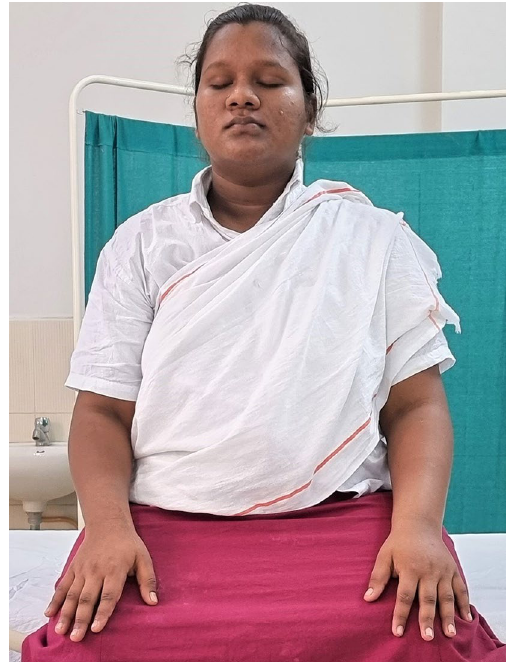
Figure 10. Sukhasana.